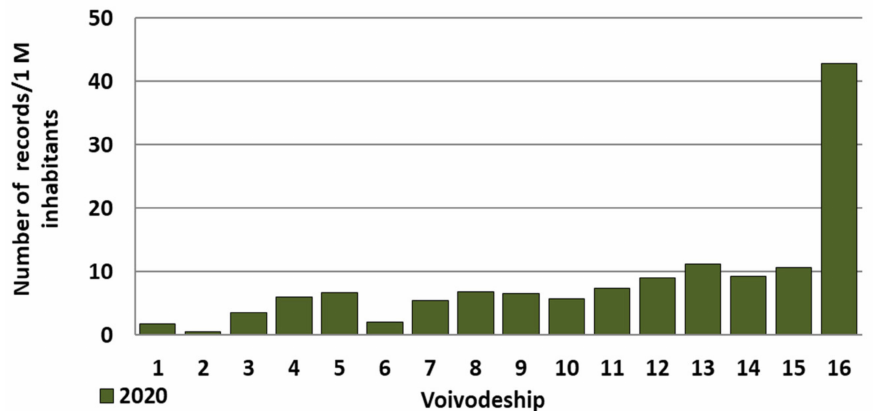
Figure 10. The number of confirmed records of Cydalima perspectalis occurrence in individual voivode- ships in 2020 per 1 M inhabitants. Axis X: 1–16—numbers assigned to individual voivodships; see Table